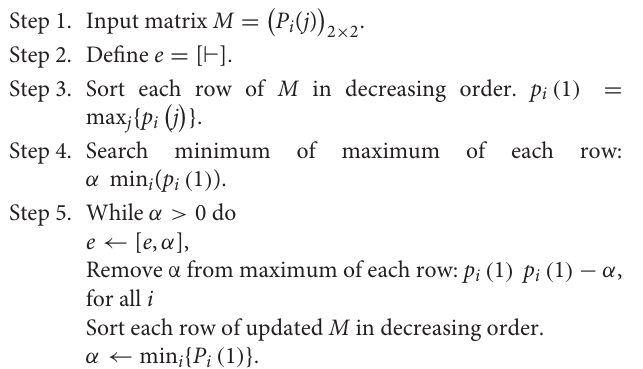
Algorithm 1 in Kocaoglu et al. (2016) can then be written as